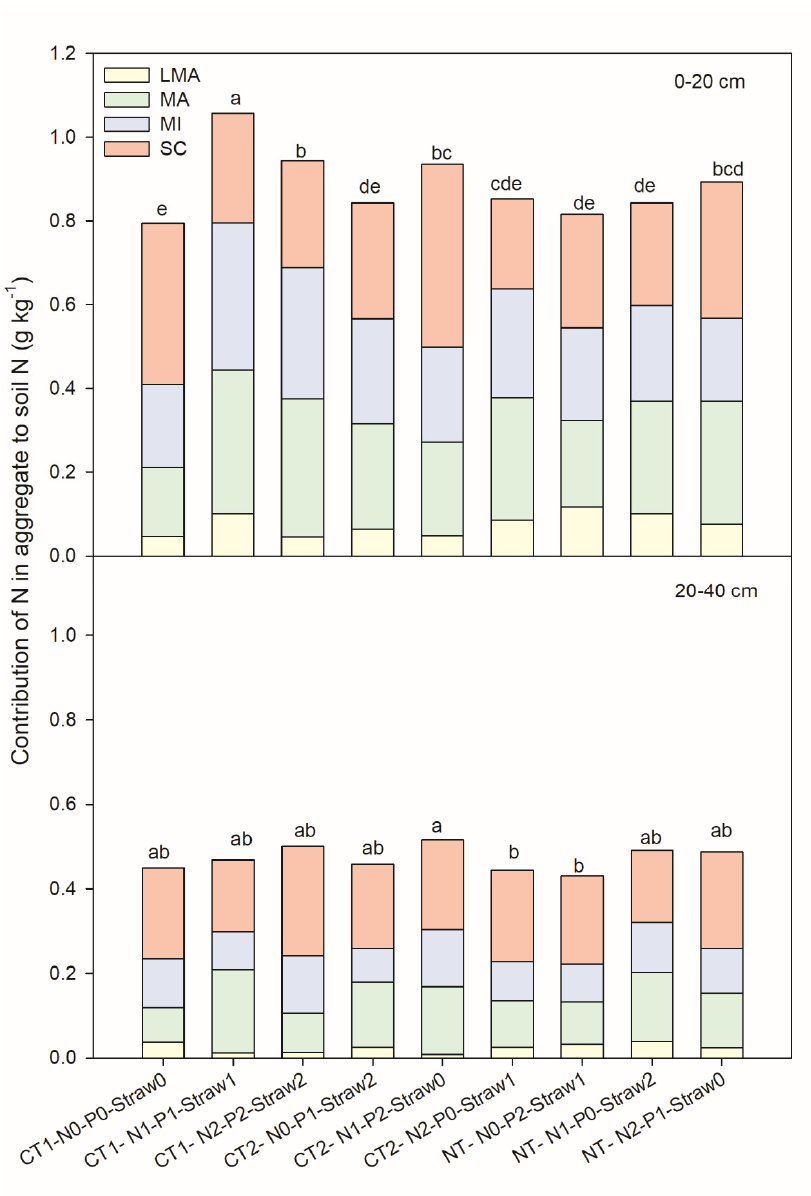
Figure 3. Nitrogen contents (g kg –1 soil) in four aggregates size fraction ( > 2, 0.25–2, 0.053–0.25, and < 0.053 mm) from 0–20 and 20–40 cm under long-term tillage and fertilization. Similar letters between treatments within a soil layer are not significantly different according to Tukey’s HSD test. CT 1 turned straw into the soil and CT 2 covered straw on the surface.